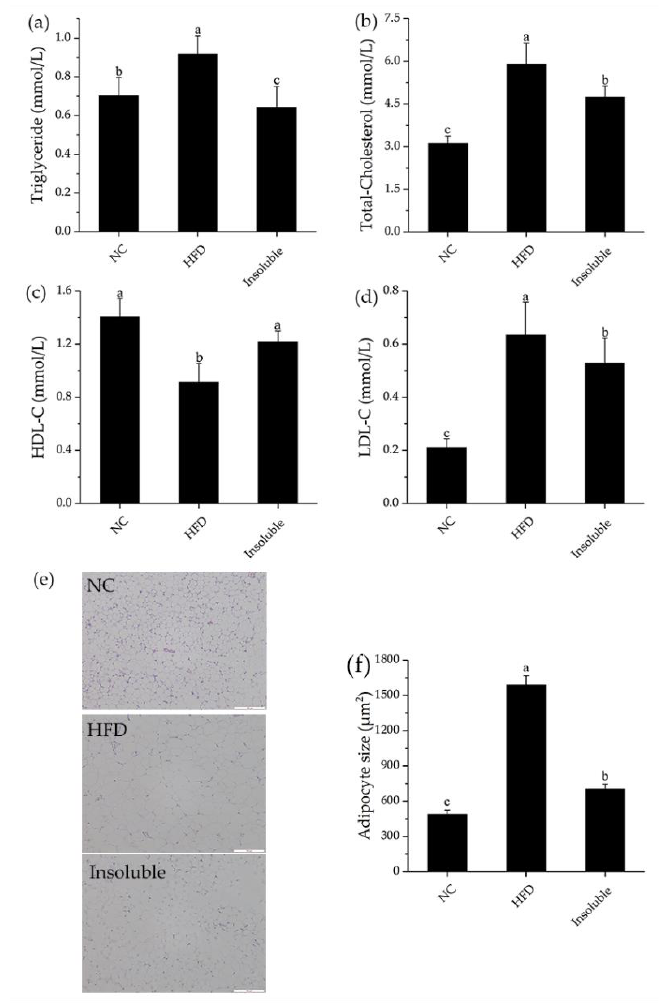
Figure 7. Effect of oral administration of water-insoluble β -glucan on serum biochemical concentrations and shape of epididymis in HFD-fed mice. ( a ) The concentration of triglycerides in serum. ( b ) The concentration of total cholesterol in serum. ( c ) The concentration of HDL-C in serum. HDL-C, high-density lipoprotein cholesterol. ( d ) The concentration of LDL-C in serum. LDL-C, low-density lipoprotein cholesterol. ( e ) Hematoxylin and eosin (H&E) staining of epididymal adipose (200 × magnification). ( f ) Adipocyte size = total cell area/the number of cells. NC, normal control group; HFD, obesity model group; Insoluble, mice fed with HFD and given oral administration of water-insoluble β -glucan. Data are presented as mean ± standard deviation (n = 6). Groups labeled with different letters are different from one another ( p <